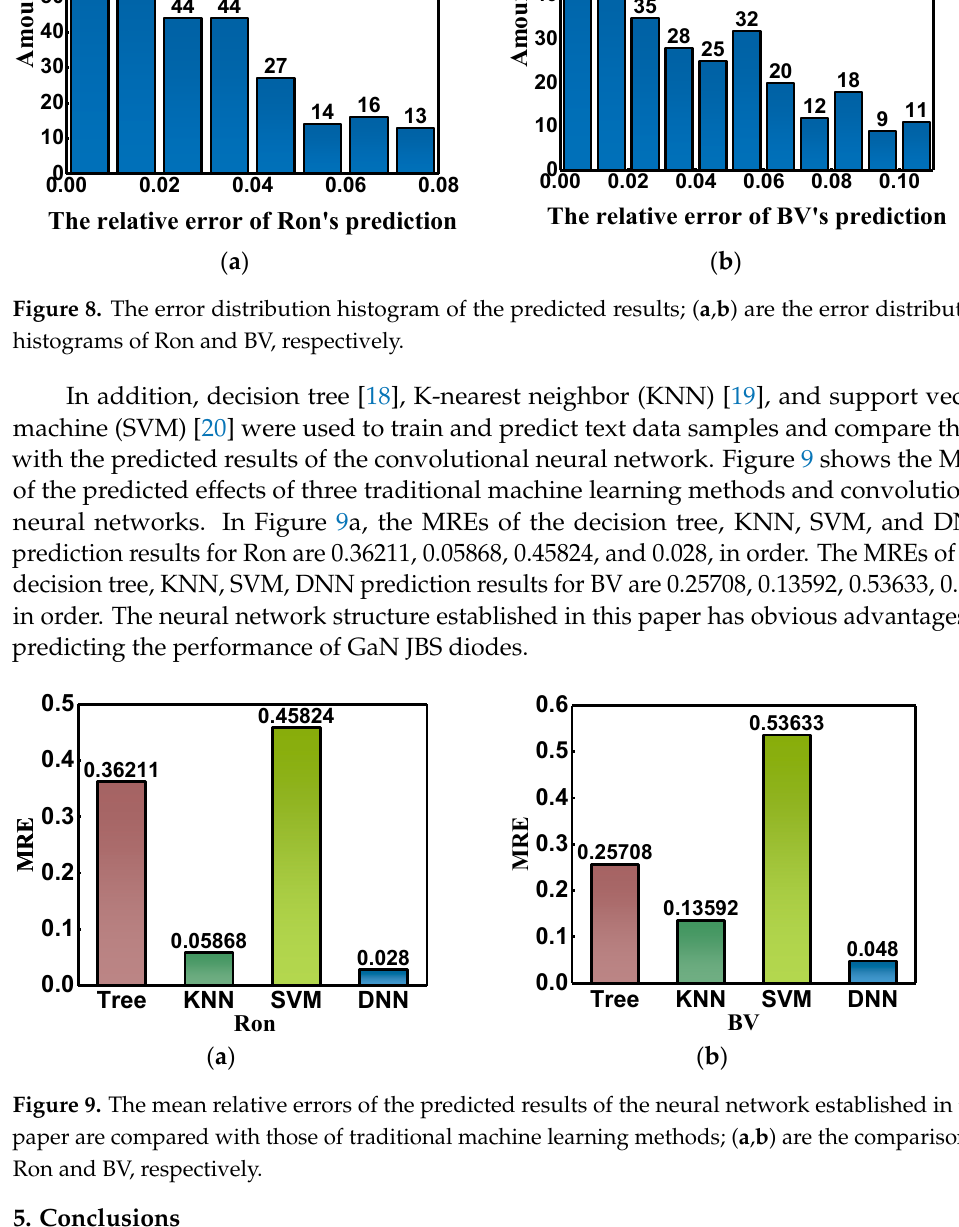
Figure 7. The prediction results of Ron and BV. ( a ) The disordered prediction results of Ron. ( b ) The prediction results of Ron under forward ranking. ( c ) The disordered prediction results of BV. ( d ) The prediction results of BV under forward order.